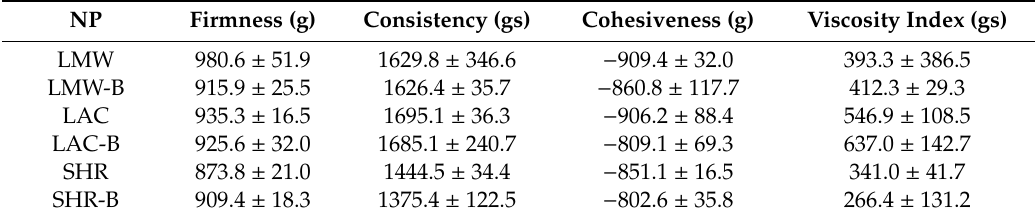
Table 4. Texture analysis of nanoparticles suspensions by back extrusion rig